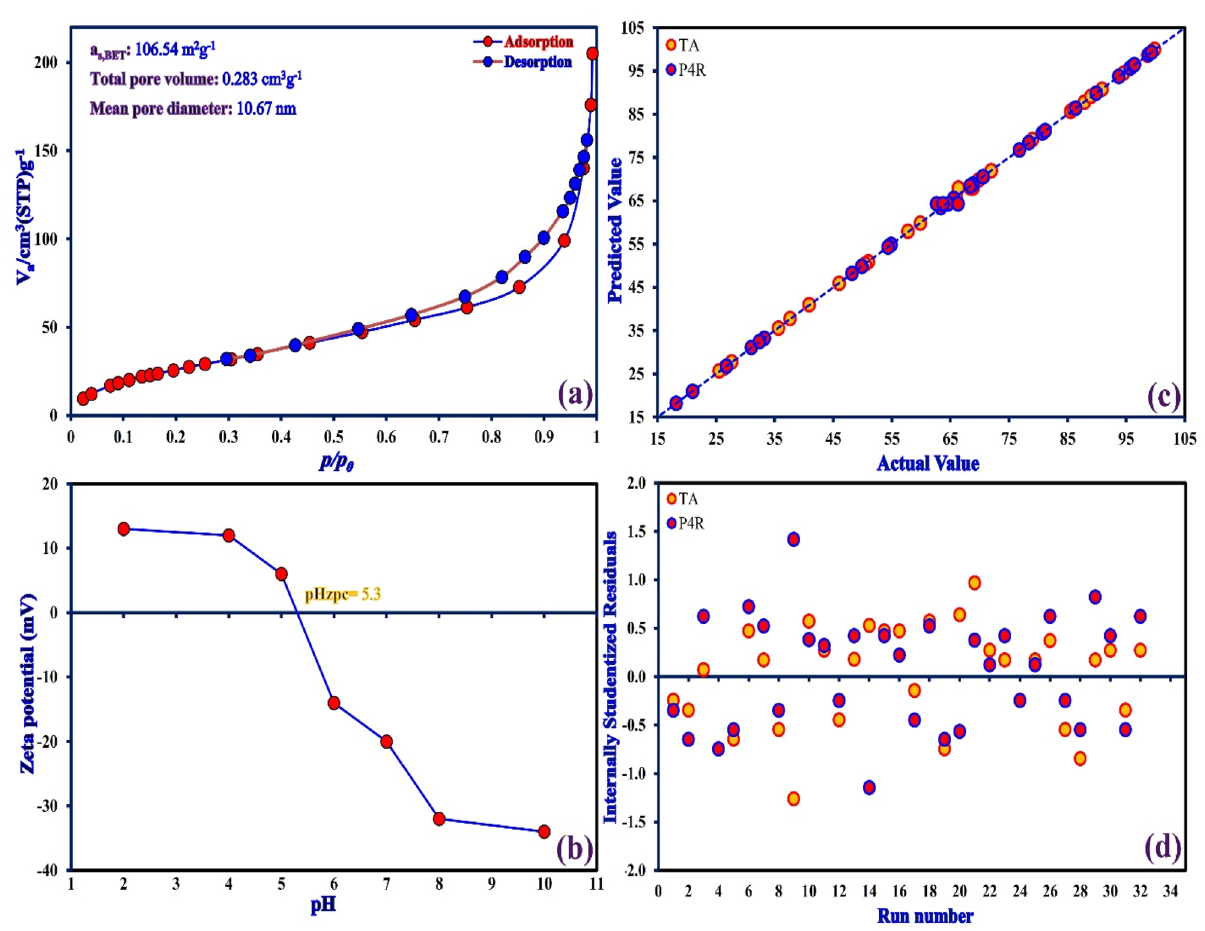
Figure 7. ( a ) Nitrogen adsorption/desorption isotherm for ZnS/CuO-CNT, ( b ) The zeta potential of ZnS/CuO- CNT as a function of pH, ( c ) The actual vs. predicted values plot, and ( d ) The residual vs. observation order plot for removal of TA and P4R